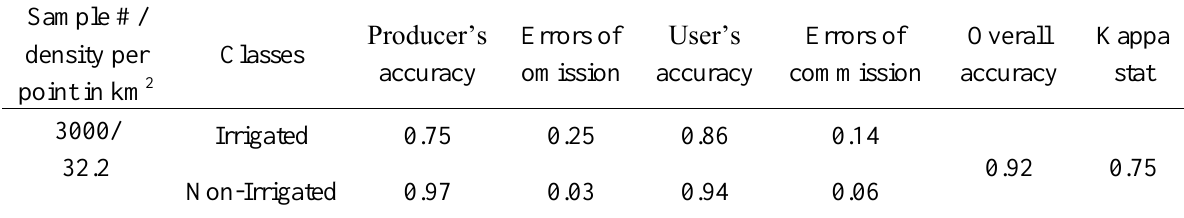
Table 2. Error matrix summary of irrigated lands between MIrAD-US and DWR fields map for